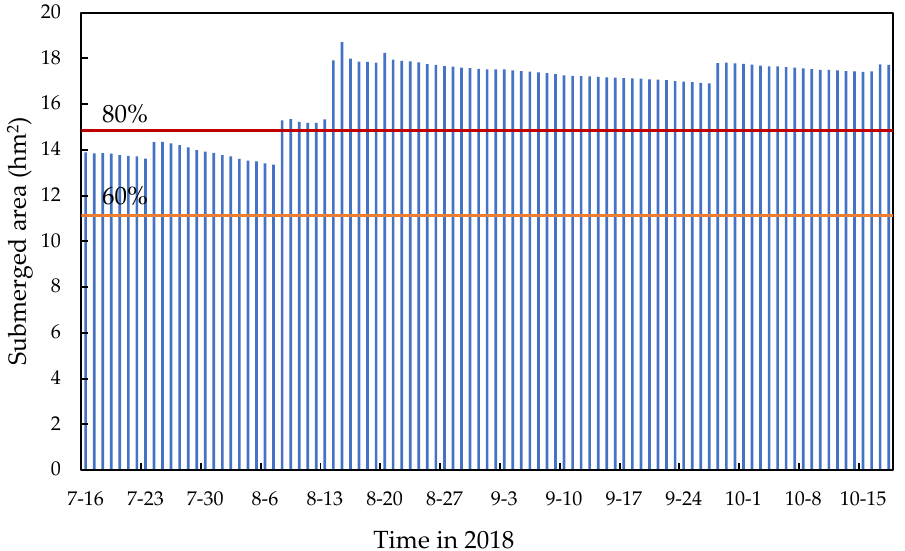
Figure 13. Histogram of inundation area of landscape water system in the study area during “the Expo Park”.